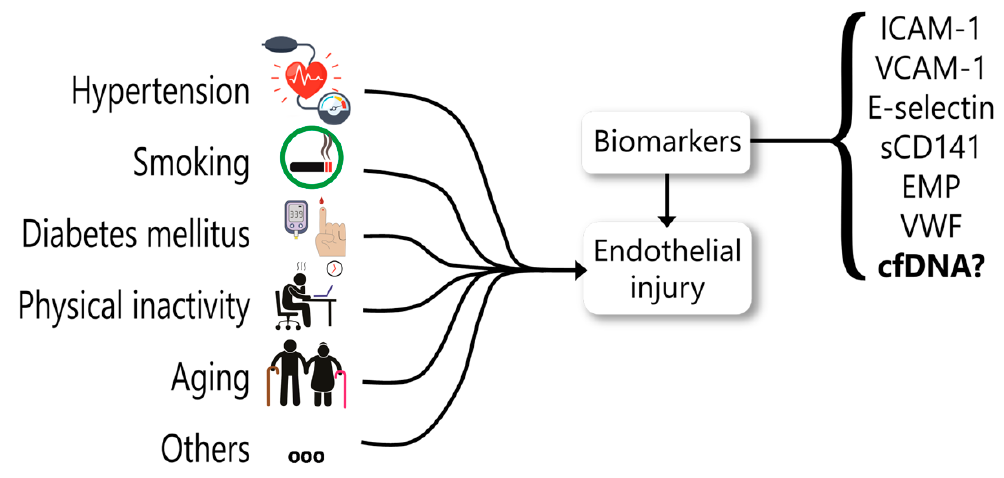
Figure 4. Circulating biomarkers proposed for endothelial dysfunction. Endothelial injury may be due to many conditions, including hypertension, diabetes mellitus, smoking, physical inactivity, aging, among others several clinical complications. Biomarkers are a valuable tool in clinical research and medical practice to identify an endothelial injury. ICAM-1: intercellular adhesion molecule 1; VCAM-1: vascular cell adhesion molecule 1; EMP: endothelial microparticles; VWF: von Willebrand factor; cfDNA: circulating cell-free DNA.